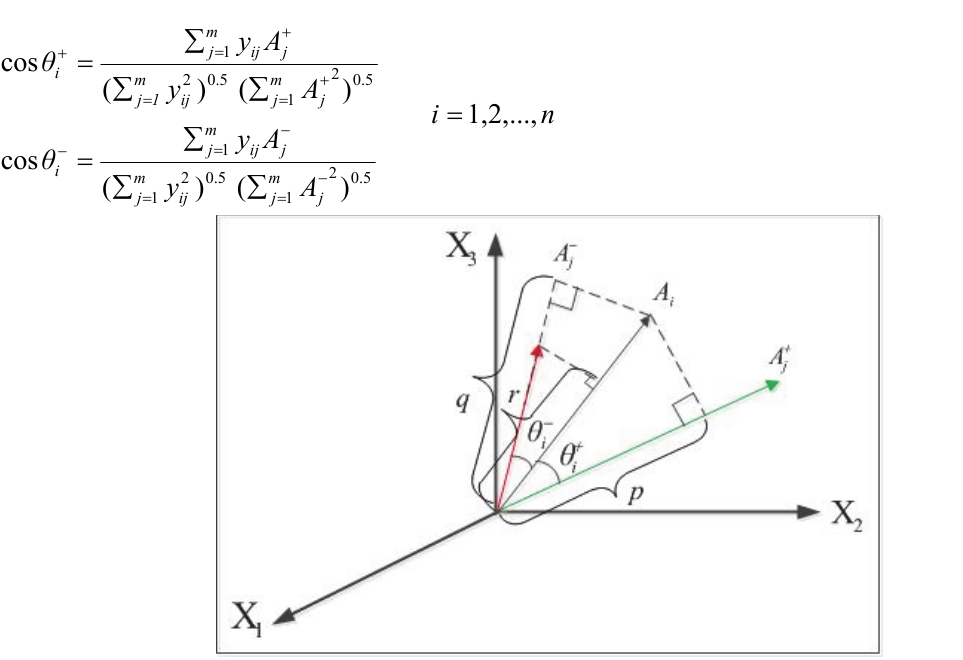
Fig. 2. Degree of conflict between alternatives